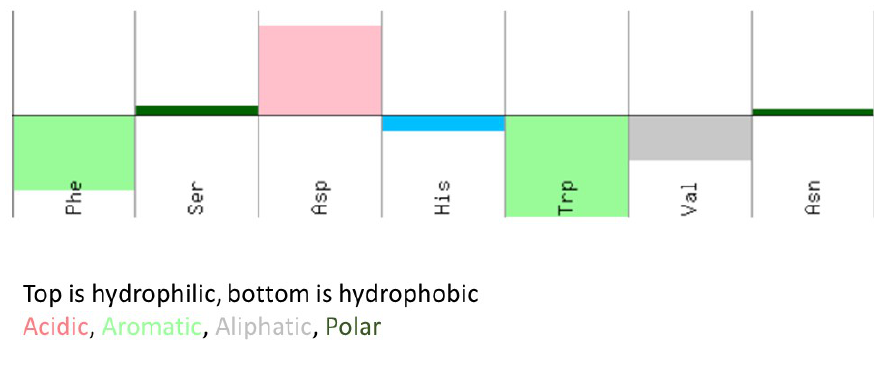
Figure 3. Hopp and Woods hydropathy scale of the selected